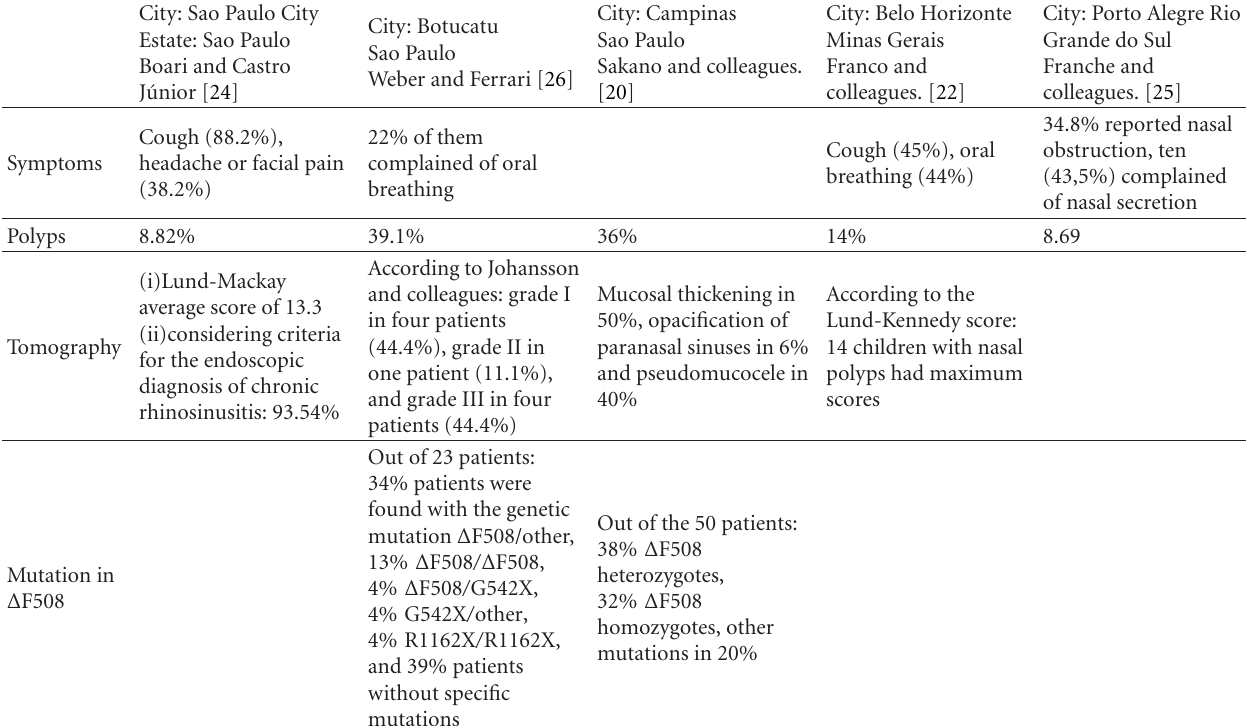
Table 1: Symptoms, polyps, tomography and mutations in Brazilian CF